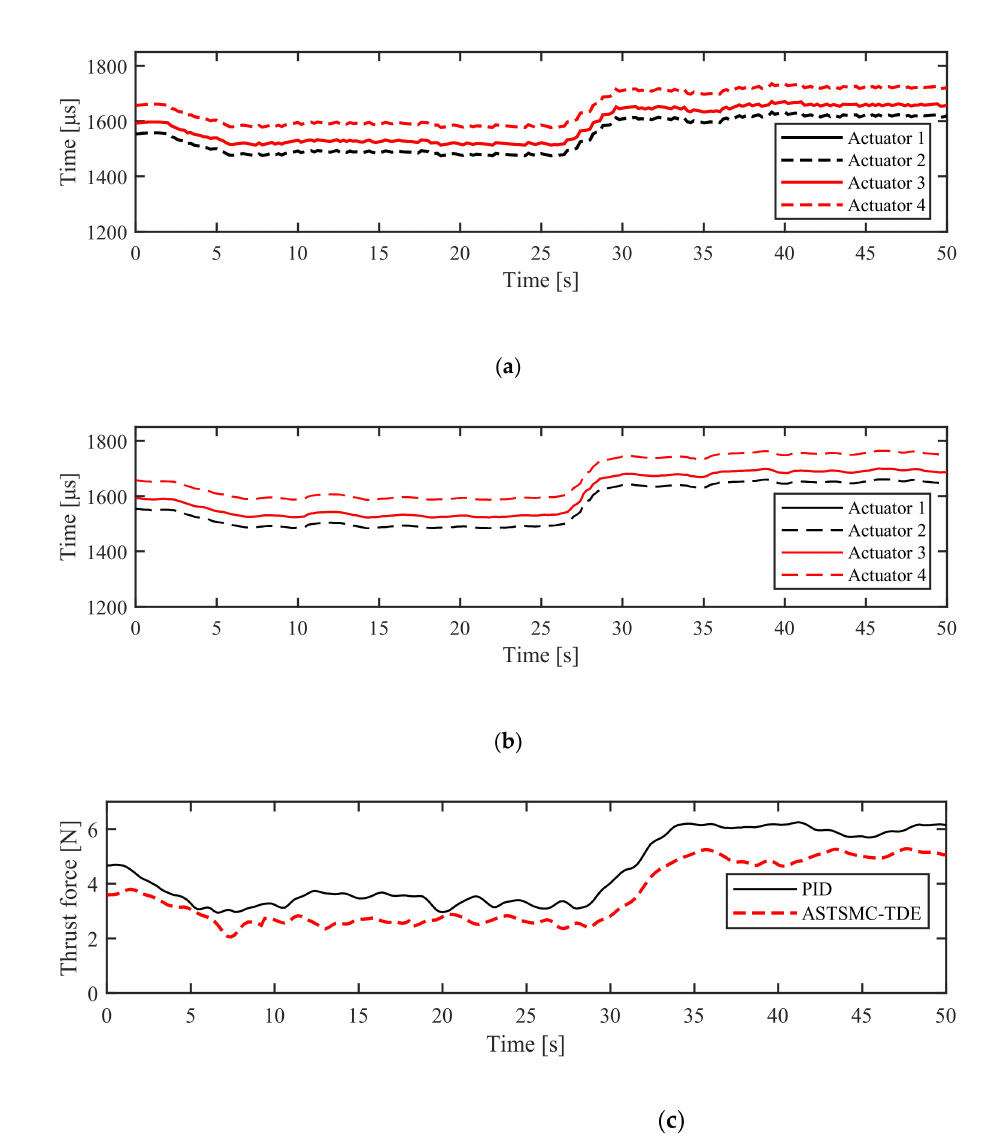
Figure 23. The experimental performance of the actuators in NM mode: ( a ) Control gains of actuators with the proposed controller; ( b ) Control gains of the actuators with the PID; ( c ) Thrust force generated by the BLDC.